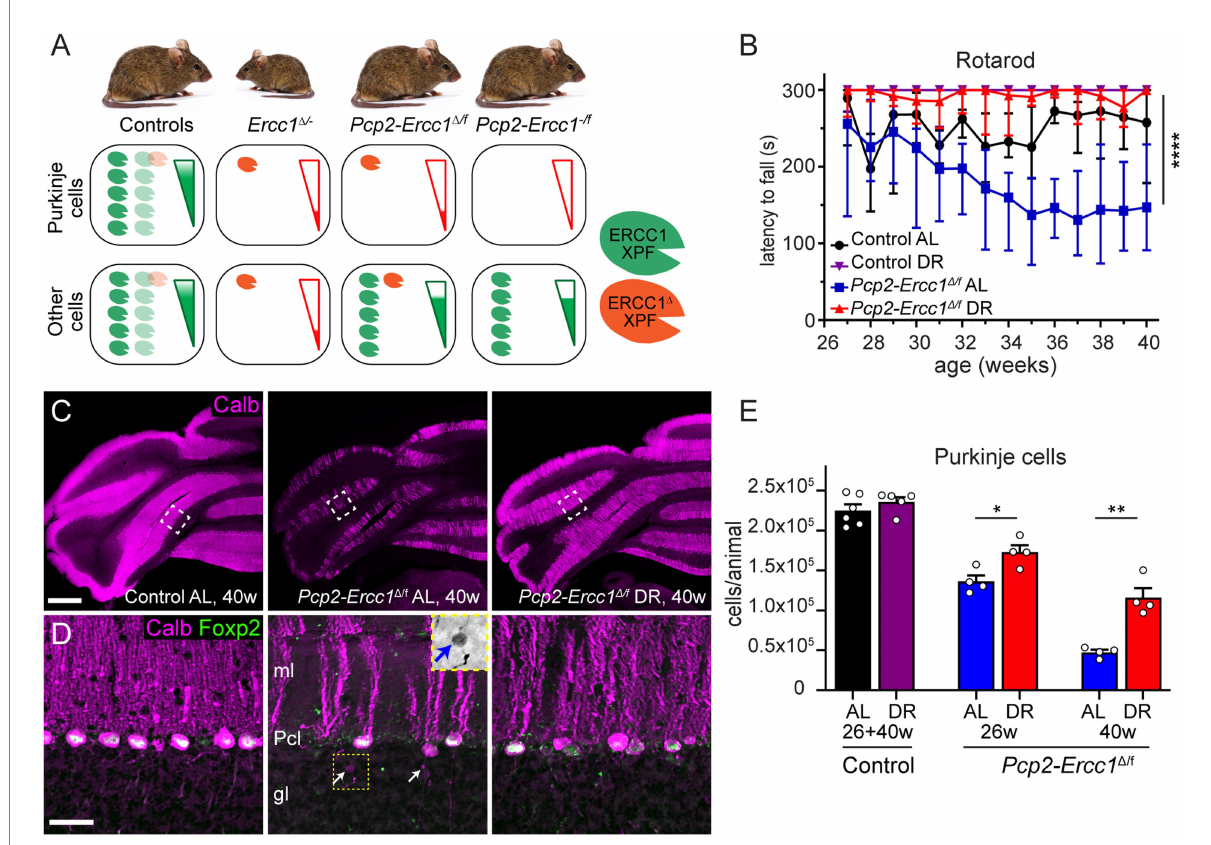
FIGURE 1 Dietary restriction reduces Purkinje cell loss in Purkinje cell specific ERCC1-deficient mice. (A) Schematic representation of Ercc1-XPF nuclease expression in Purkinje cells versus other cells in the Ercc1 mouse models of this study. The truncated Ercc1 Δ allele results in strongly reduced levels of ERCC1 Δ -XPF nuclease dimer (one red symbol) as compared to wild-type Ercc1 + allele (5 green symbols). Ercc1 Δ /− mice have low mutant ERCC1 production in their whole body, whereas the hypomorphic mutation in the Pcp2-Ercc1 Δ /f mice is restricted to Purkinje cells. In comparison, Pcp2- Ercc1 −/f mice have no ERCC1 production in Purkinje cells, whereas the remainder of the body in both conditional mutants is repair-proficient due to the flox-allele that encodes wt protein. The genotype and ERCC1-XPF levels in littermates used as control animals for each cohort differ as indicated with light colored heterodimers (see methods). (B) Accelerating rotarod assay showing preserved performance in DR versus AL Pcp2 - Ercc1 Δ /f mice over time. Values represent medians with interquartile range ( n = 4/group); **** p < 0.0001 (Dunn’s post-test; Pcp2 - Ercc1 Δ /f AL versus DR). (C,D) Low (C) and high magnification (D) confocal images of calbindin (magenta) and FOXP2 (green) immunostaining to outline Purkinje cells and their nucleus. Note, reduced loss of Purkinje cells in DR- vs AL-treated Pcp2 - Ercc1 Δ /f mice. Insert in middle panel in d shows an increased- contrast inverted-signal image of the axonal spheroid indicated by the yellow arrow in the same panel. gl, granular layer; ml, molecular layer; Pcl, Purkinje cell layer. (E) Bar graph with means ± SE of stereological quantification of Purkinje cells showing loss of Purkinje cells in 26-and 40-week- old Pcp2 - Ercc1 Δ /f mice and reduced loss in DR vs. AL animals. ( n ≥ 4/group); * p < 0.05, ** p < 0.01 (unpaired t -tests for each cohort). Scale bars: 500 μm (C) , 25 μm (D)